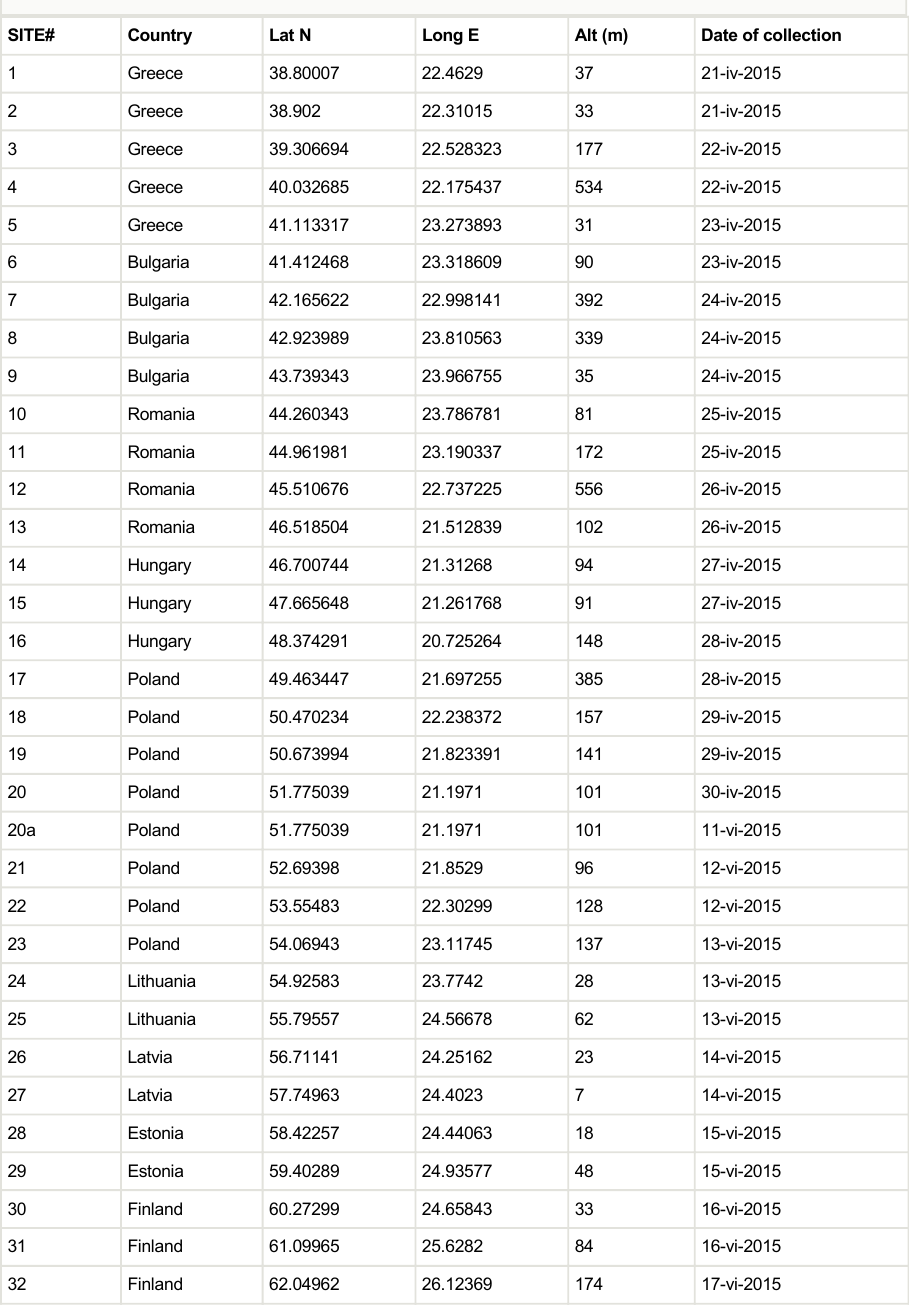
Table 1. Basic site details. See Cronk et al. (2015) for further